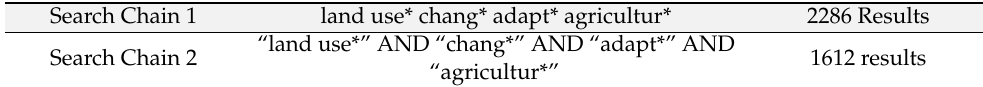
Table 3. Search chains deployed in ISI Web of Science.